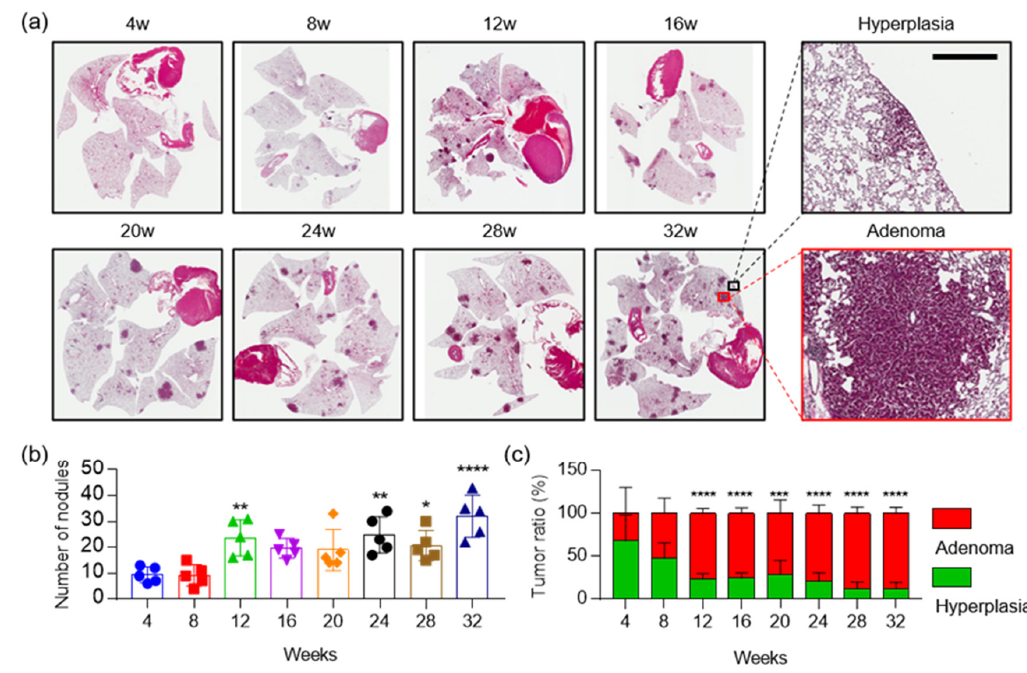
Figure 4. Characterizations of Kras LA2 mice lungs. ( a ) Representative photomicrographs of hematoxylin and eosin (H&E) staining in mouse lungs, harvested from 4 to 32 weeks after birth. Black box indicates hyperplastic lesion and red box indicates adenoma in 32 weeks of Kras LA2 mice lung, respectively. The scale bar represents 400 μ m. ( b ) Quantitative analysis of number of tumor nodules in mouse lungs from 4 to 32 weeks after birth ( n = 5). ( c ) Kras LA2 mice lungs were analyzed and all lesions were classified for hyperplasia and adenoma. p -values were obtained by one-way or two-way ANOVA test and are indicated by asterisks (* p < 0.05, ** p < 0.01, *** p < 0.001 and **** p < 0.0001).